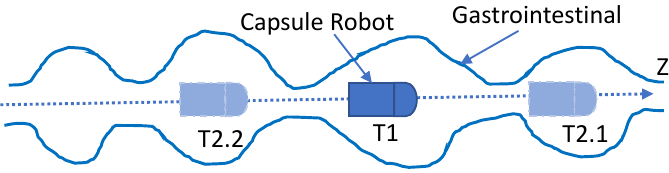
Figure 3. The state of the capsule robot during squirming of the GI. Z is the direction of the exit. T 1 means the current position of the capsule robot. T 2.1 denotes the next possible position when the robot is moving forward, and T 2.2 denotes the next possible position when the robot is moving